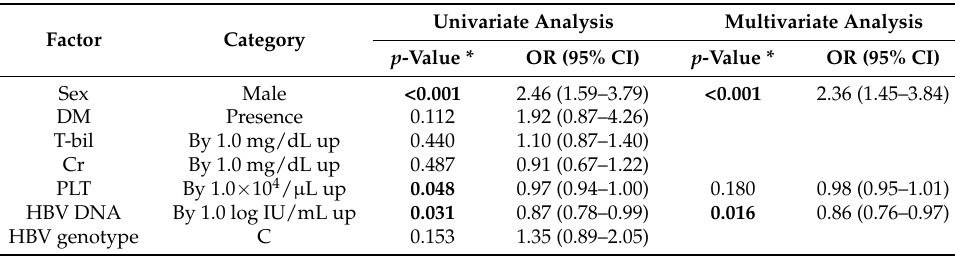
Table 4. Univariate and multivariate logistic regression analysis of baseline factors associated with non-achievement of ALT normalization (JSH criteria) at 1 year.